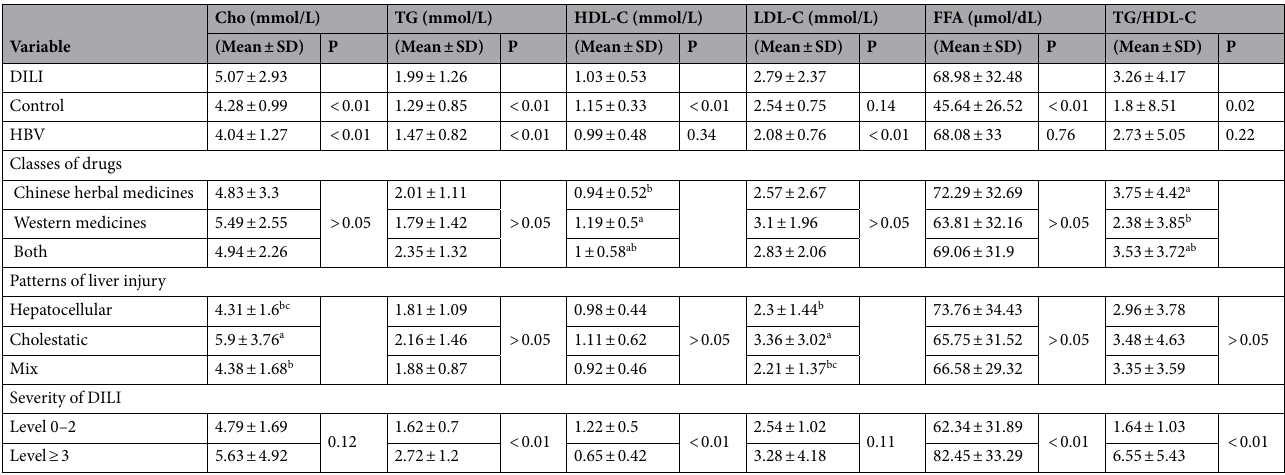
Table 4. Dyslipidemia and TG/HDL-C ratio in classes of DILI and control group. TG triglyceride, Cho cholesterol, LDL-C low-density lipoprotein cholesterol, HDL-C high-density lipoprotein cholesterol, FFA free fatty acid, DILI drug induced liver injury. abc: significant difference (P ≤ 0.05) was shown between different letters.